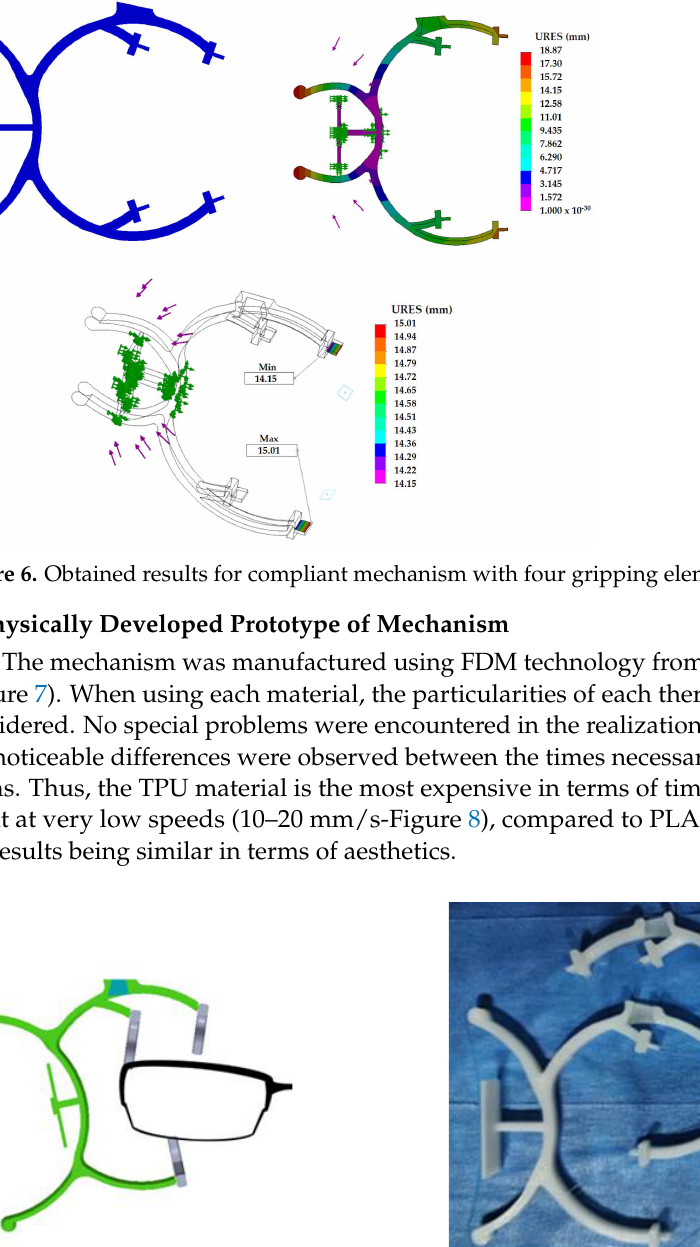
Figure 5. Comparison of force-displacement characteristics for investigated materials.